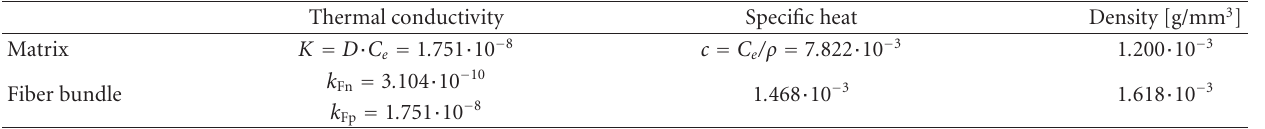
Table 3: Material properties of carbon-braided RUC from the heat-di ff usion